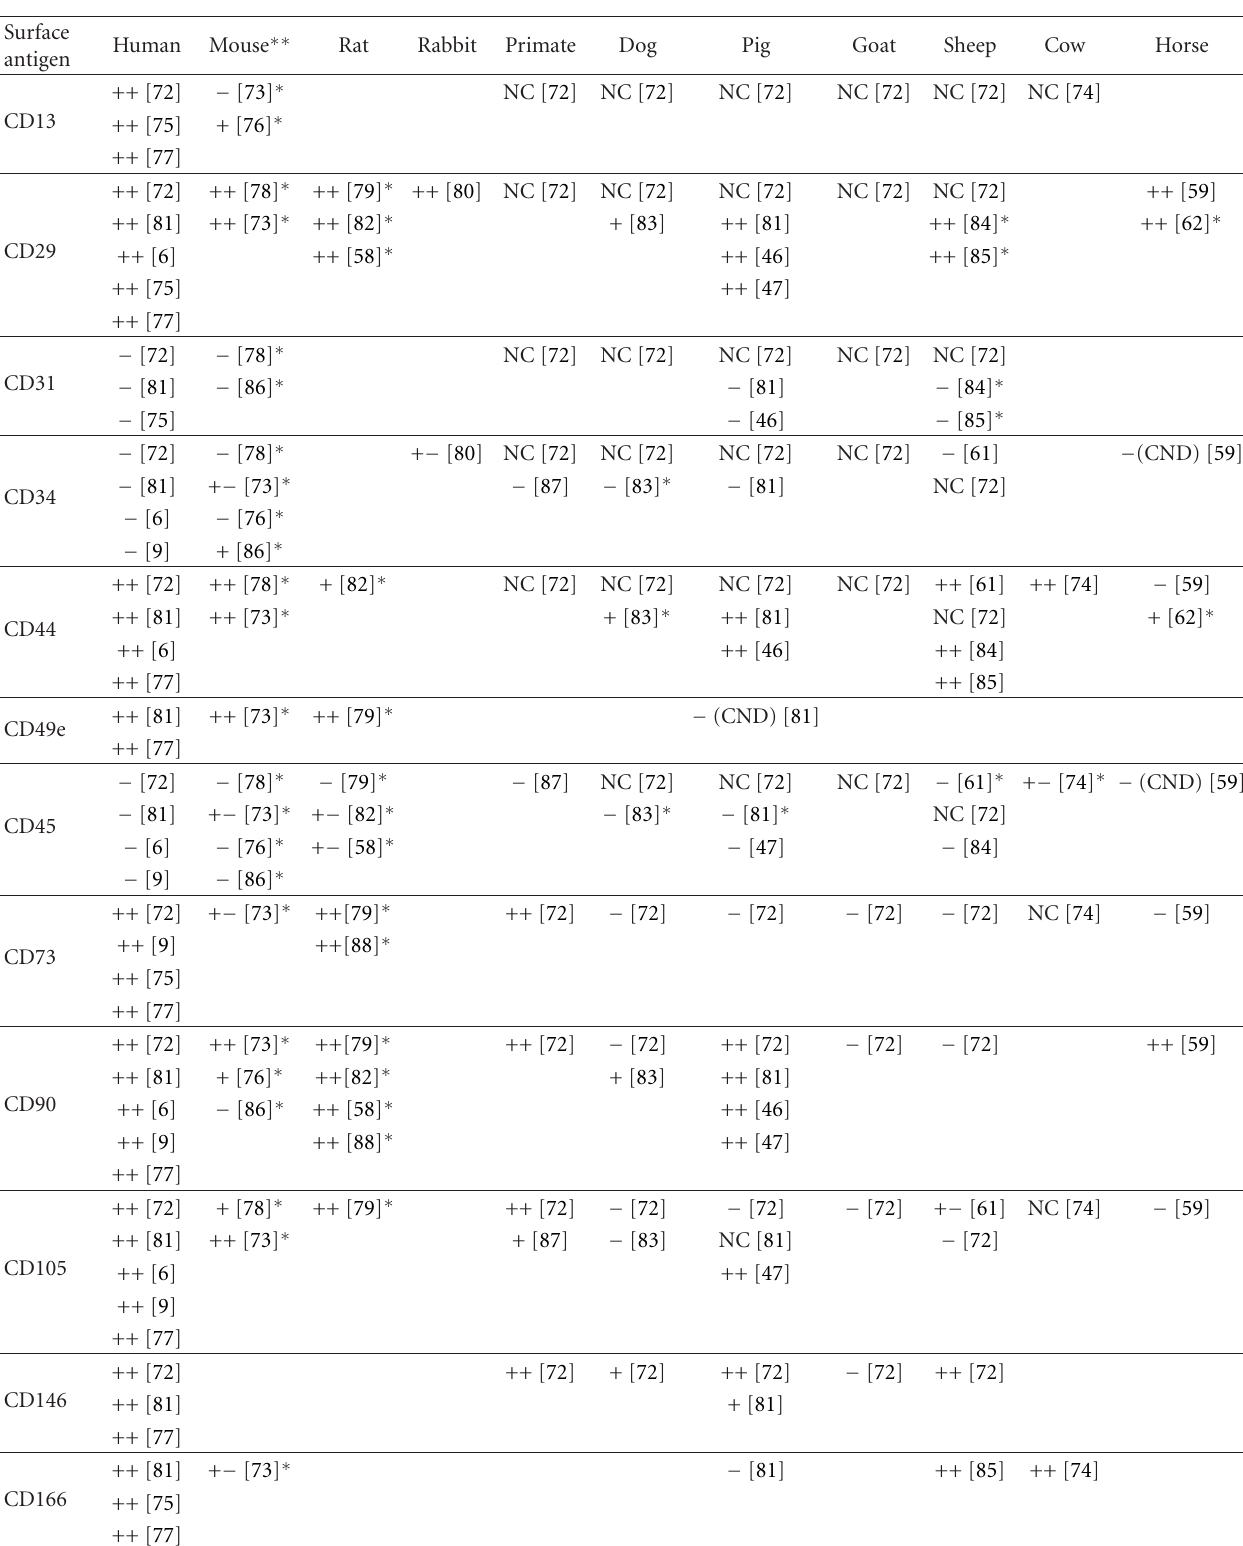
Table 1: Surface antigen expression on cultured MSCs from di ff erent